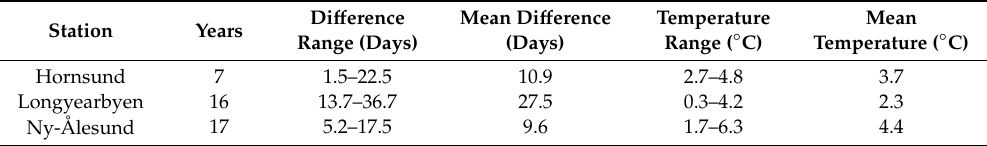
Figure 12. Relationship between mean daily temperature (in the period between snow disappearance and GSO), and the length of the time between snow disappearance and GSO calculated for Hornsund, Svea, Longyearbyen and Ny-Ålesund. Table 3. Summary of the minimum, maximum, mean and variance in the di ff erence between first snow-free day and growing season onset, and the mean daily temperature in the period between FSFD and